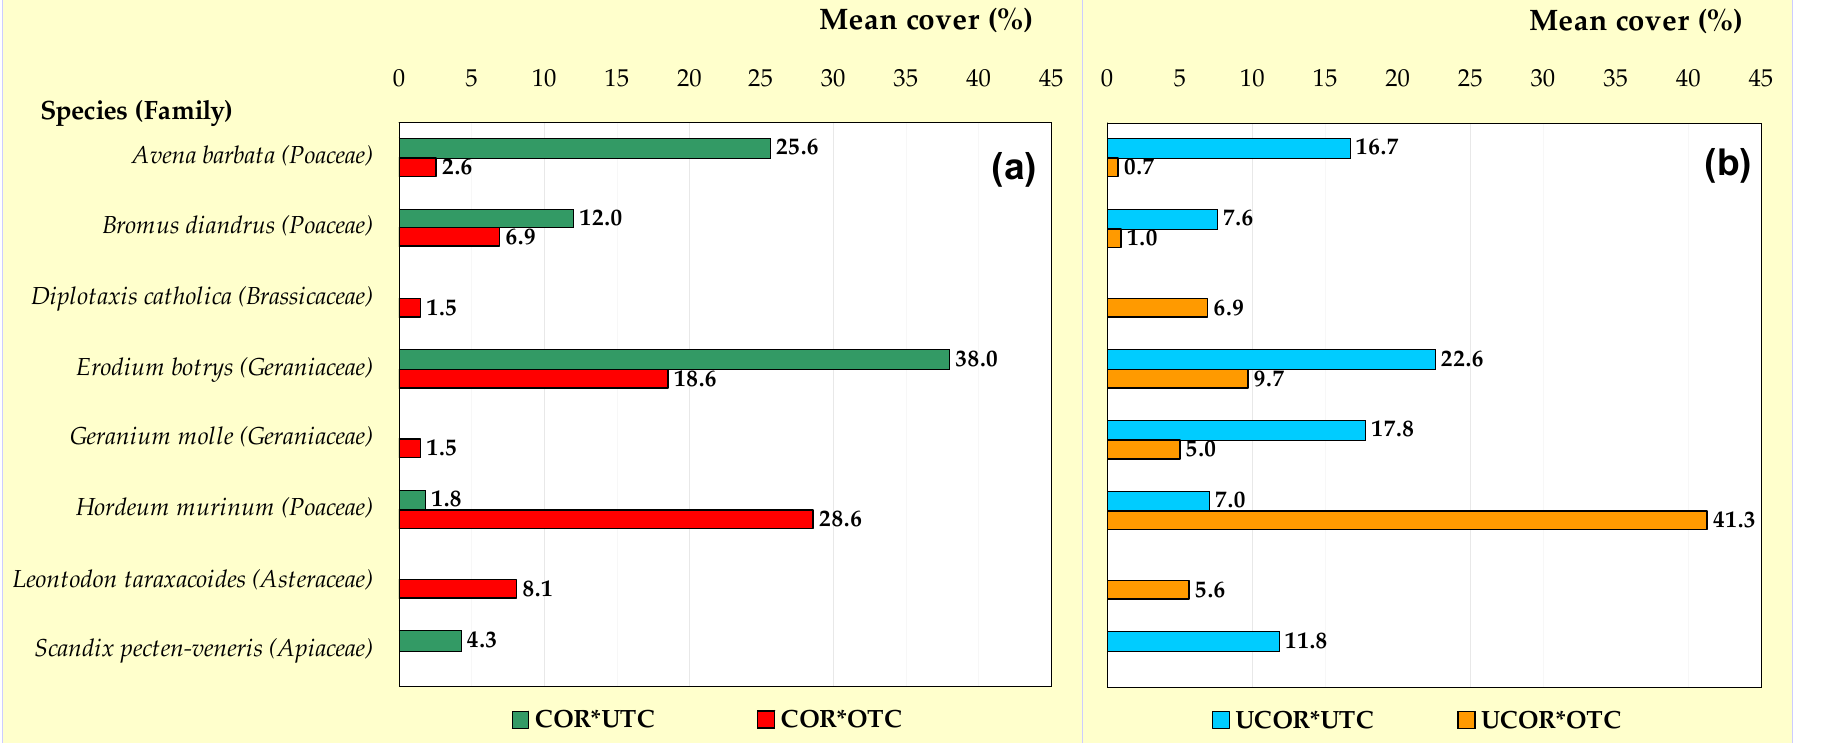
Figure 8. Species (and their families) with greater representation in amended areas (COR; ( a )) and in unamended areas (UCOR; ( b )), under tree canopy (UTC) and outside tree canopy (OTC).